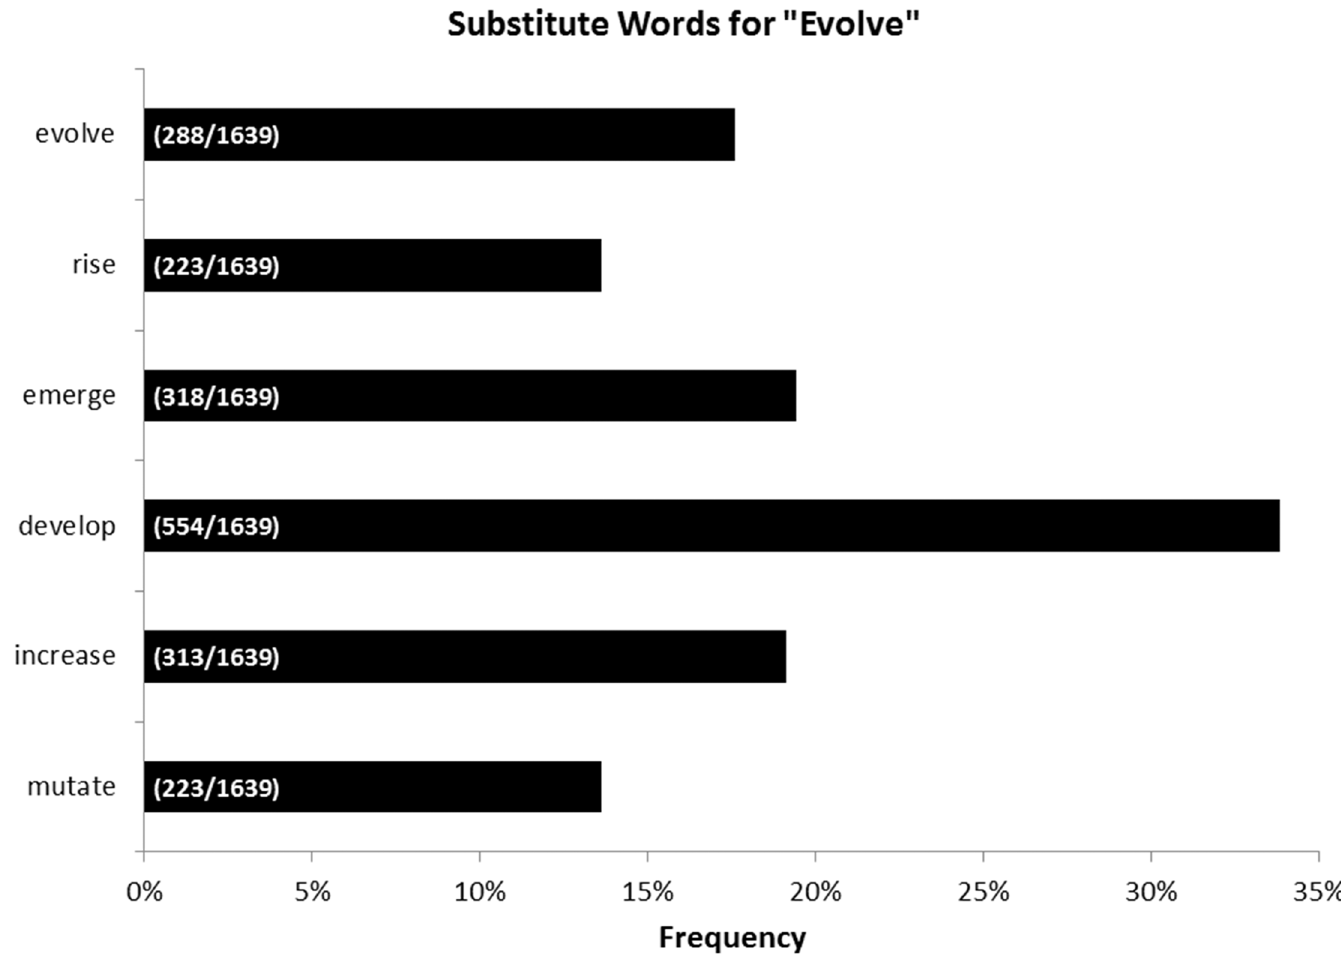
Fig 3. Substitute Words for “ Evolve. ” Frequencies that the word “ evolve ” or substitute words for “ evolve ” are used for all relevant newspapers examined. Parenthetical bar labels indicate: (number of relevant articles using the indicated word / number of relevant articles examined).